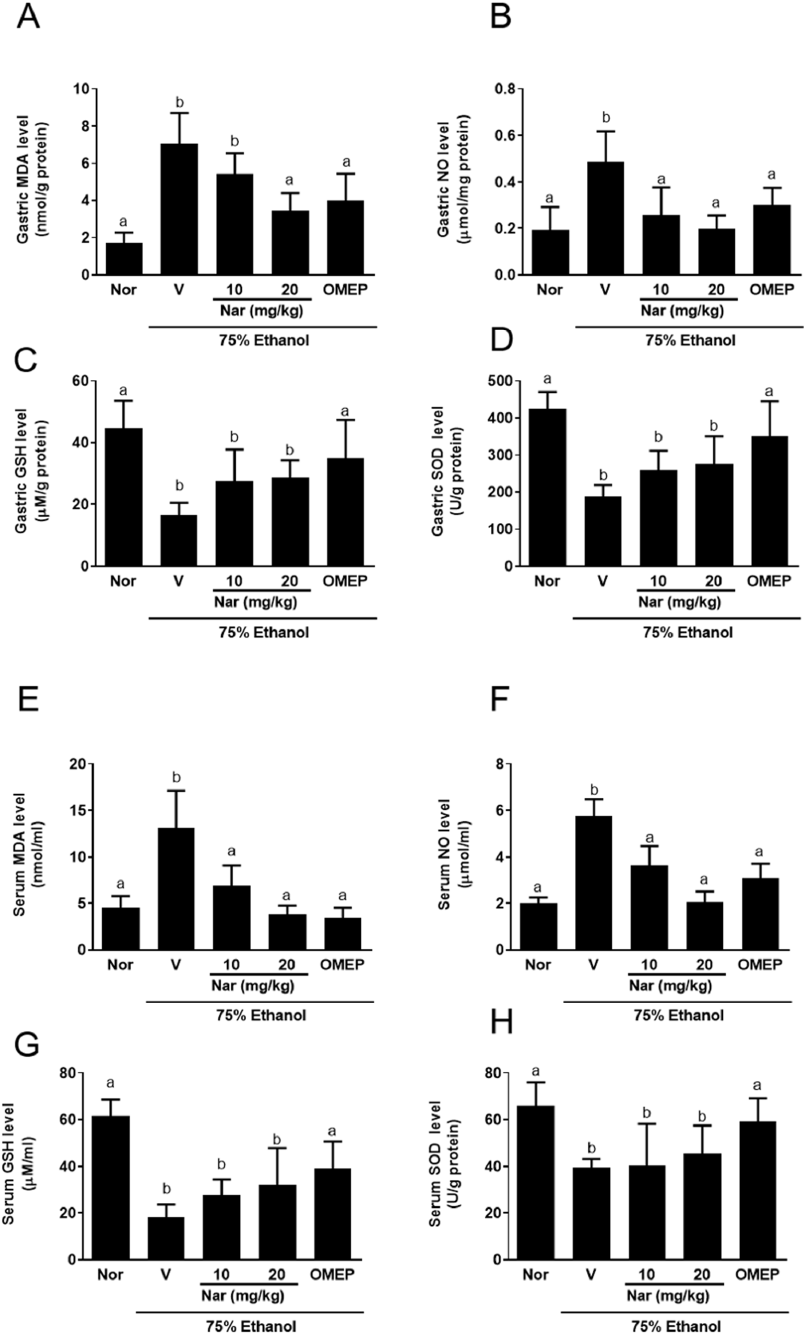
Figure 4. Effect of naringenin on ethanol-induced oxidative stress. The levels of nitric oxide (NO), malondialdehyde (MDA) and, GSH and SOD in the stomach homogenate ( A – D ) and the serum ( E – H ) were elevated by ulcer induction and lowered by pretreatment with the naringenin. The vehicle (10% dimethyl sulfoxide (DMSO) and 90% glyceryl trioctanoate), naringenin (Nar, 10 and 20 mg/kg) and omeprazole (OMEP, 20 mg/kg; used as a positive control) were given orally for a period of 3 days. After fasting for 12 h prior to the experiment, mice were fed orally with ethanol (0.5 mL/100 g body weight) to induce the acute ulcer. After 4 h, mice were sacrificed. The data obtained from individual animal samples per group were averaged ( n = 6); values represent mean ± standard deviation (SD). Statistical comparison was analyzed by a one-way ANOVA followed by Tukey’s multiple comparison tests. Bars not sharing a common letter represent a statistically significant difference from each other ( p < 0.05). In the normal control group, the mice only received vehicle (Normal). Nor, normal; V,